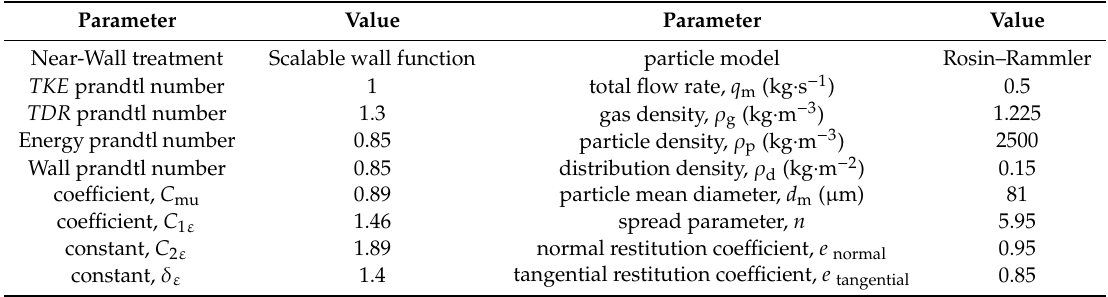
Table 2. Simulation